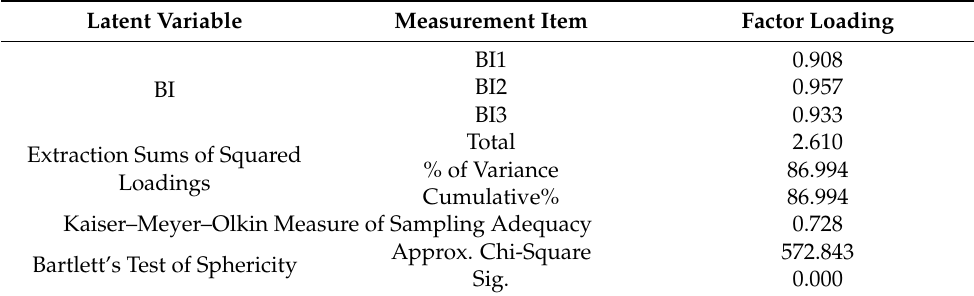
Table 5. Structural validity test results of BI.